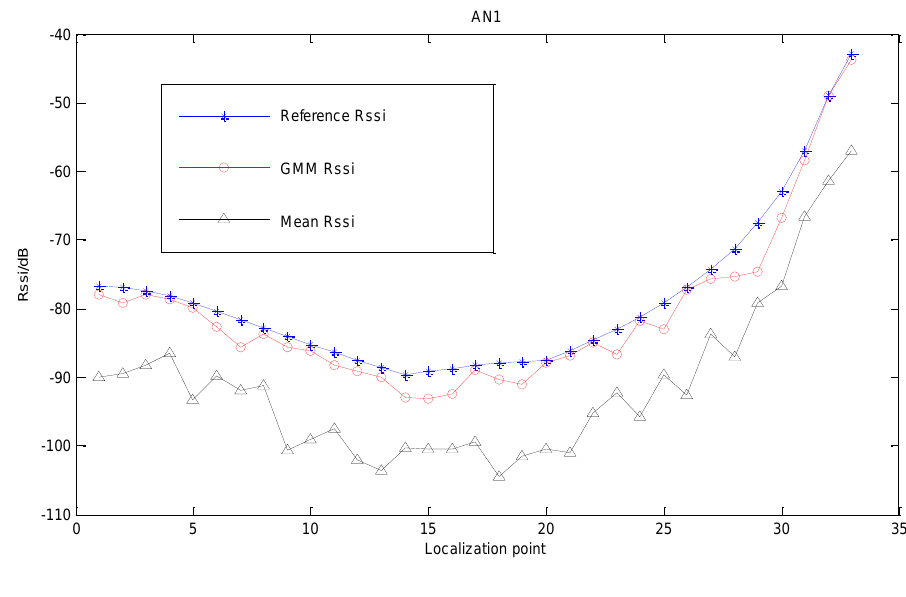
Figure 4. Result of RSSI estimation.